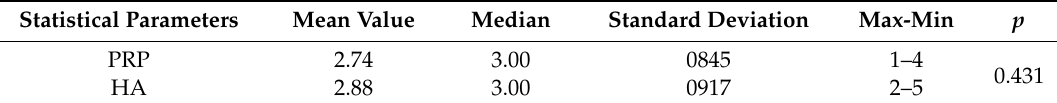
Table 3. Statistical parameters of the mean points of temporomandibular joint’s pain after management. Statistical Parameters